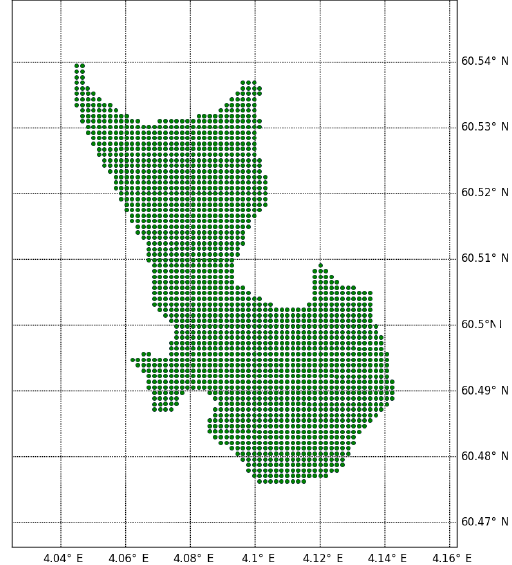
Figure 3. Oil drift simulation initialised by seeding 2000 oil el- ements within contours of an oil slick as observed from satellite (Radarsat2). The contour is imported from a Geography Markup Language (GML) file produced by Kongsberg Satellite Services